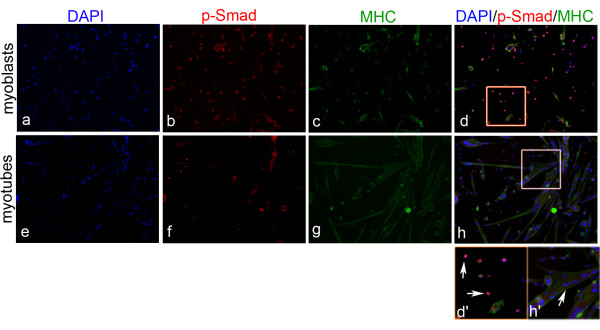
The response to BMP signals decreases during late differentiation stages. (A-H) Myoblasts were cultured for 9 days under differentiation conditions and double immunolabeled for p-Smad (B,F) and MHC (C,G). Nuclei were counterstained with DAPI (A,E). Boxed areas in the overlay images (D,H) are enlarged in (D',H'). p-Smad phosphorylation is strongly reduced in fused myotubes (white arrows in H') but is clearly present in mononucleated myoblasts (white arrows in d'). Magnification is 100×.